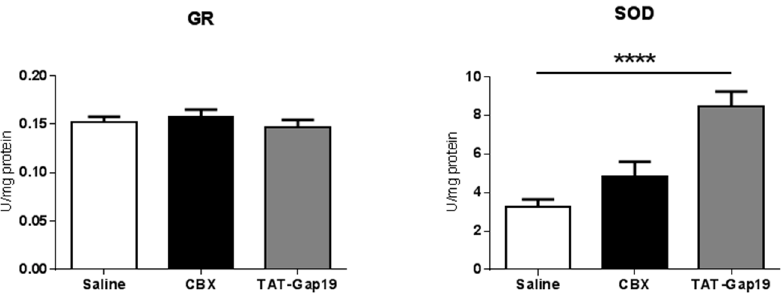
Figure 4. Effects of CBX and TAT-Gap19 on anti-oxidative enzyme activity after TAA-induced chronic hepatic injury in mice. Mice were administered TAA intraperitoneally for 8 weeks. Initially, mice ( n = 8/group) were administered with 100 mg TAA/kg body weight, followed by 10% weekly increments to the utmost dose of approximately 200 mg TAA/kg body weight. Thereafter, an osmotic pump was implanted in the peritoneal cavity, which ensured the release of 1 mg TAT-Gap19 or CBX/kg body weight/day or saline for two weeks. The activity of the anti-oxidant enzymes catalase, glutathione peroxidase (GPx), glutathione reductase (GR), and superoxide dismutase (SOD) was evaluated in liver tissue. Results were analyzed by 1-way ANOVA followed by post hoc Bonferroni correction. Data were expressed as means ± SEM (* p ≤ 0.05; **** p ≤ 0.0001).